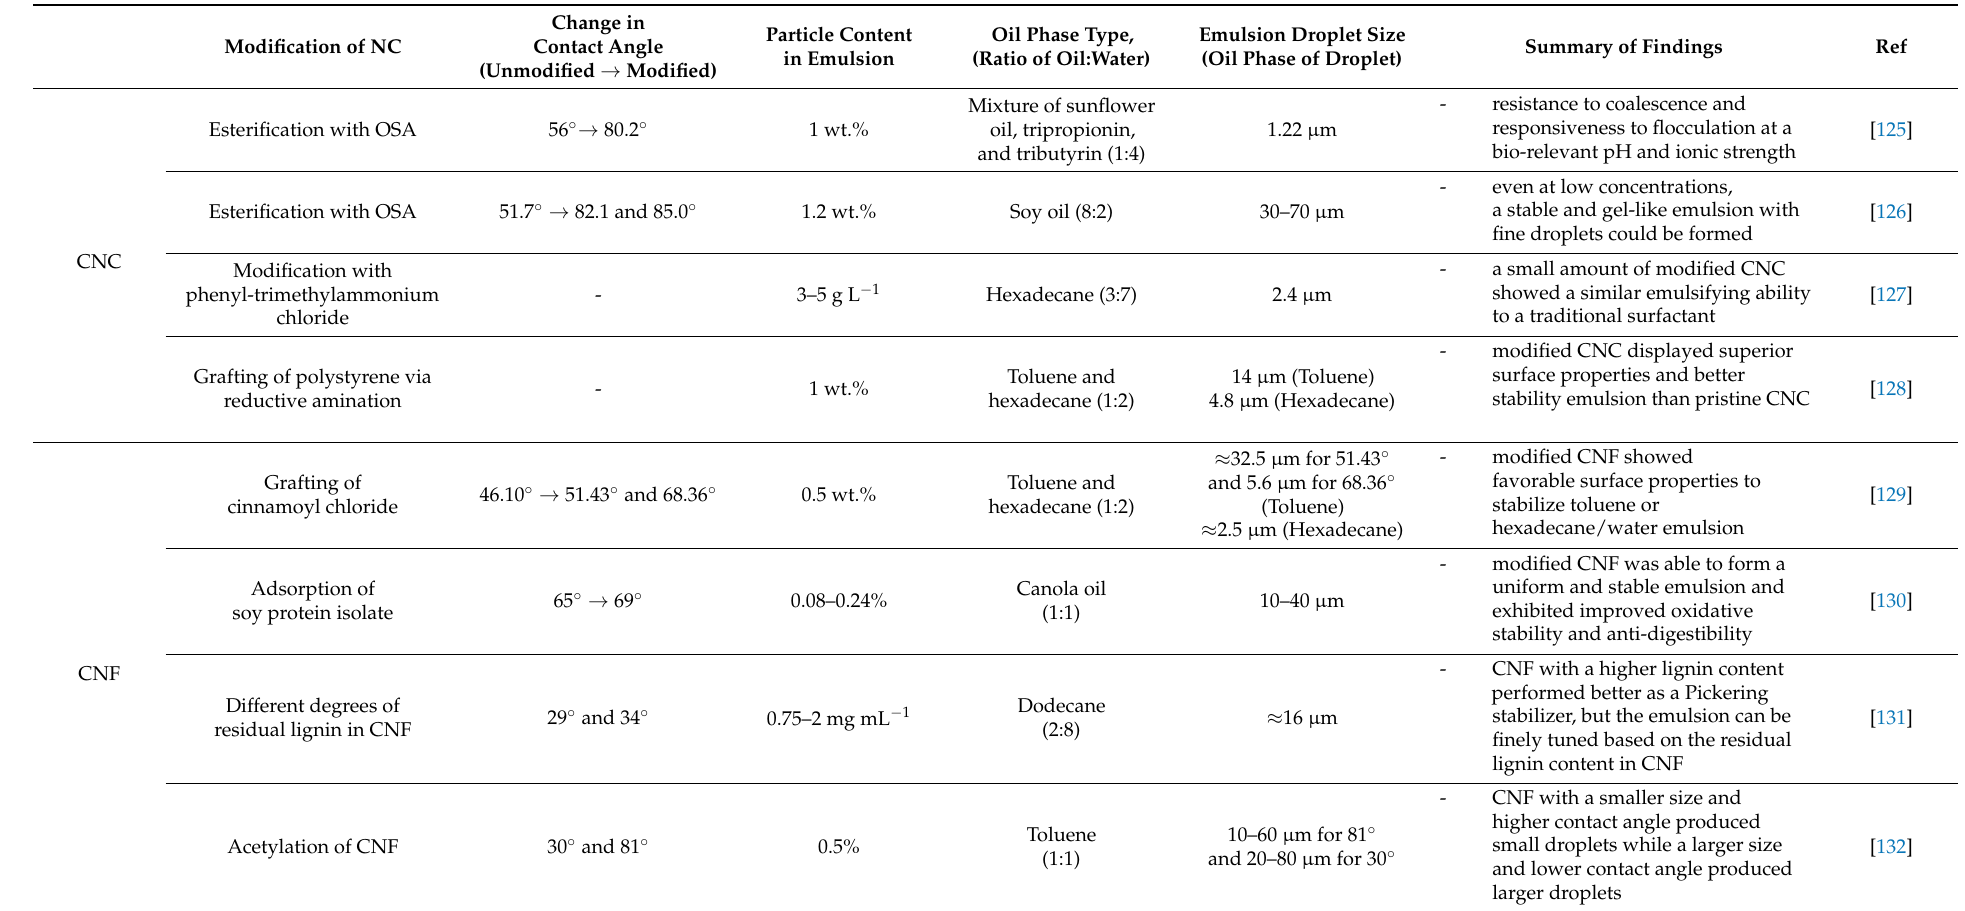
Table 4. Summary of the scientific studies on the different surface wettability of CNC and CNF derivatives in their use as Pickering